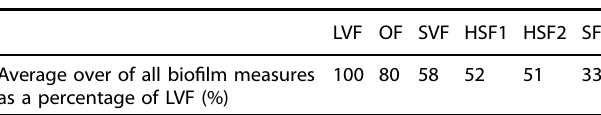
Fig. 5 Characteristics of the bio fi lms that accumulate on the slides on the channel walls for experiment set 2 at three different locations, inlet, middle and outlet, and the average across the whole wall. a The percentage of the slide covered with bio fi lm. b The percentage covered by EPS alone. c The bio fi lm thickness. d The bio fi lm density. The error bars in the histrograms represent + /- one standard deviation. Table 2. Comparison between bio fi lm